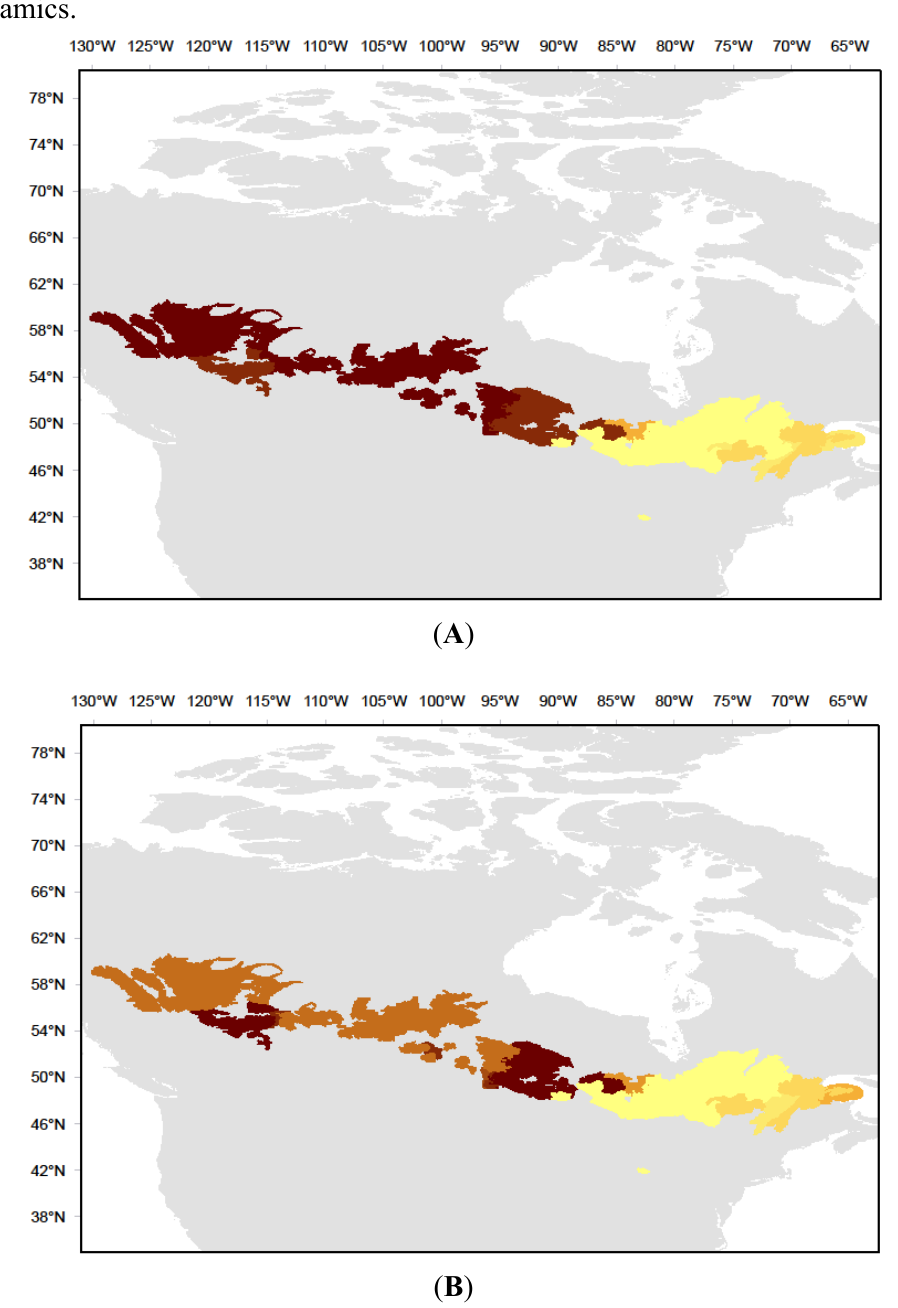
Figure 4. ( A ) Northern lying (deeper shades) aspen forests are more sensitive to productivity drivers relative to more southern stands (lighter shades) along a north south temperature gradient; ( B ) Areas that are more responsive to growth drivers along an east-west precipitation gradient. The darker the shade, the higher the sensitivity of the